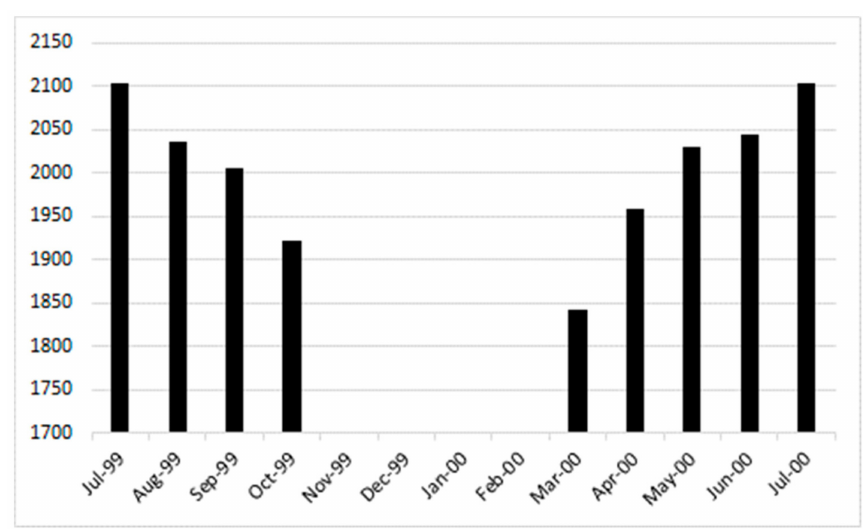
Figure 2. Time of emergence by month, which closely follows the time of dusk, about ten minutes after the reported time of sunset. Times on Y-axis are in Central Standard Time. There was no emergence between November and February, inclusive.